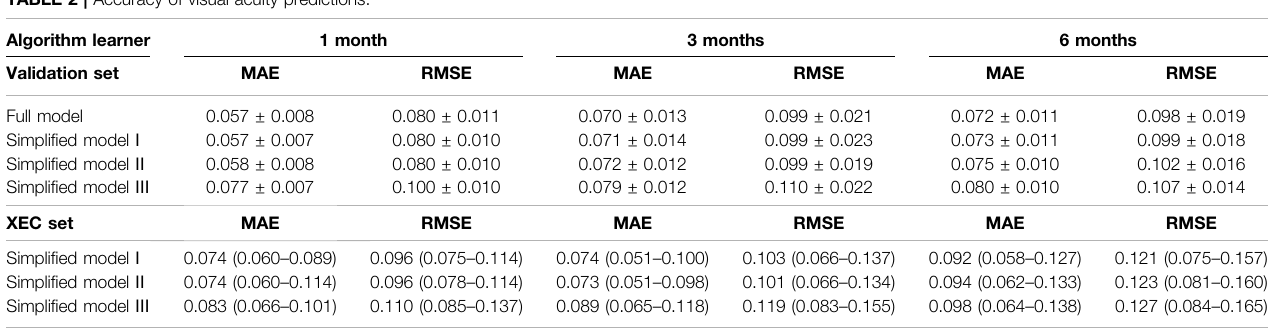
TABLE 2 | Accuracy of visual acuity predictions. Algorithm